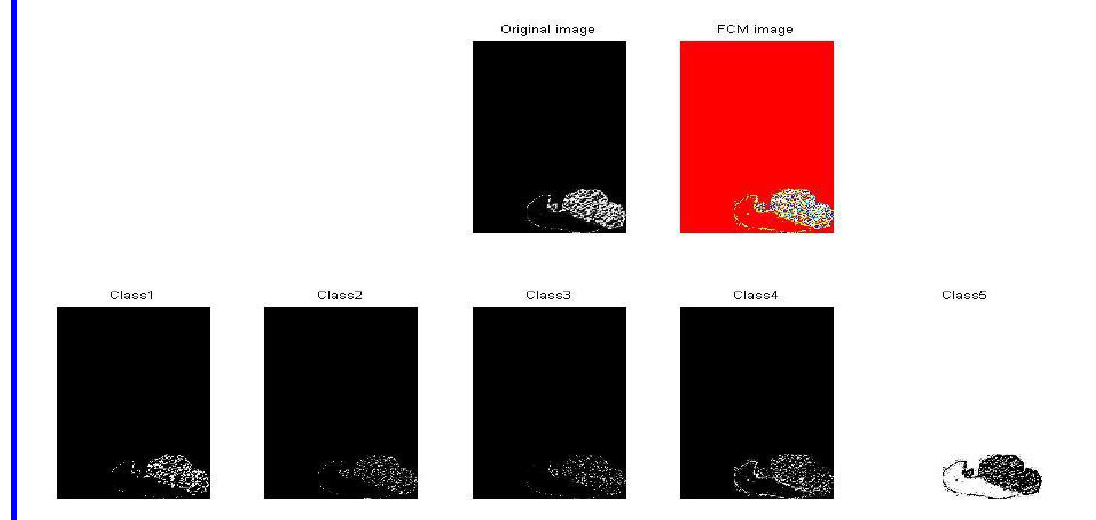
Fig. 6: FCM clustering for case1 benign (noncancerous) with 5 classes, the tumor appears in class 5.